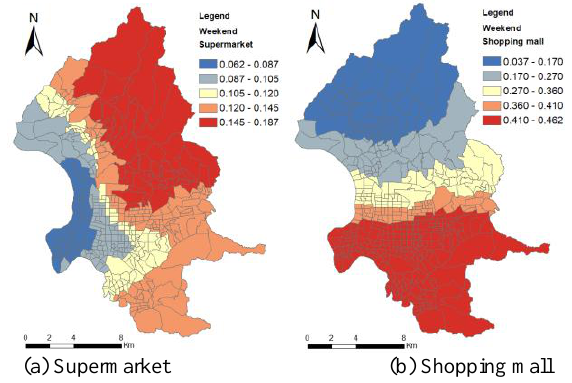
Figure 3. The spatial distribution of commercial area (a) Supermarket; (b) shopping mall parameter estimation delivery